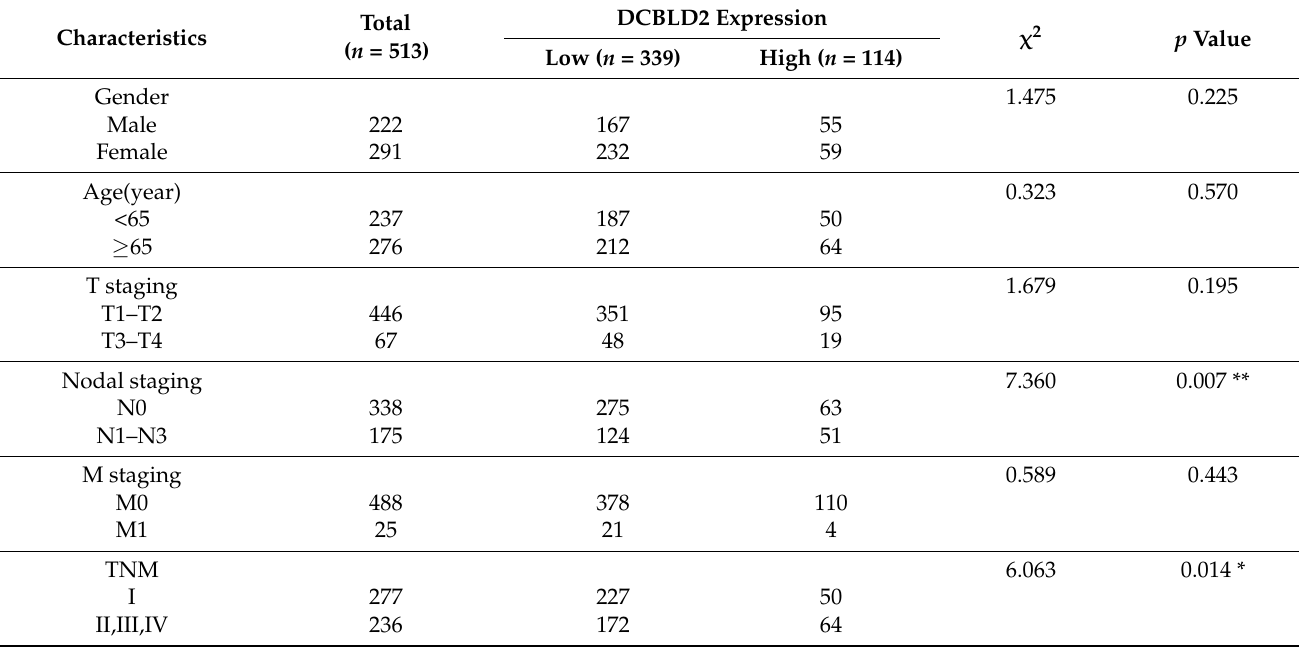
Table 1. Association between DCBLD2 mRNA expression and clinicopathological features of patients with LUAD from the